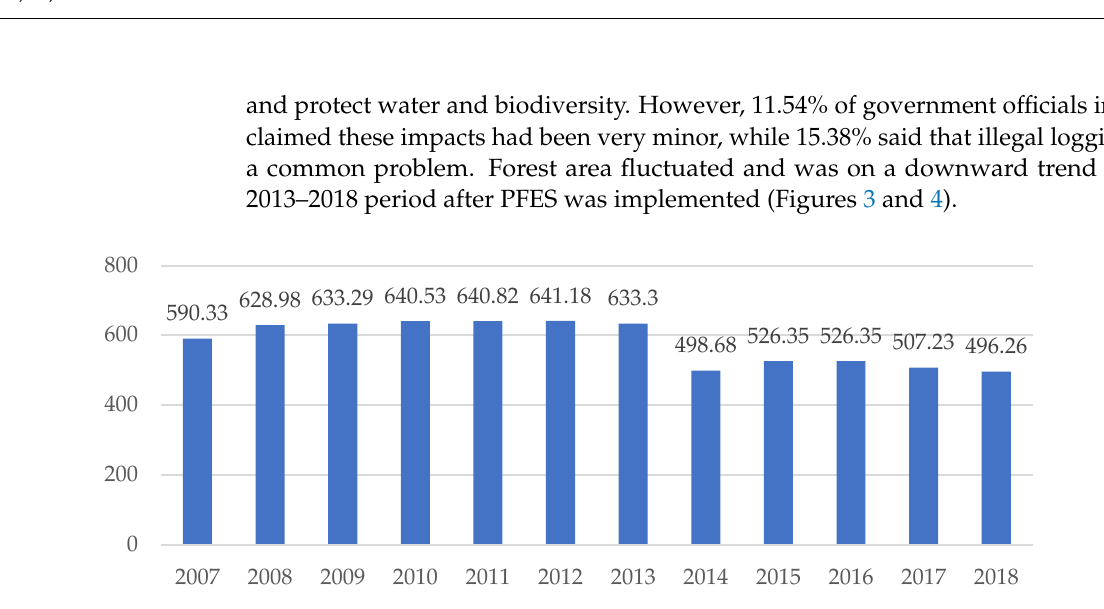
Figure 3. Forest area change in Dak Lak province, 2007–2018 (ha × 1000). Source: Reproduced with permission from Dak Lak Forest Protection Department [67].